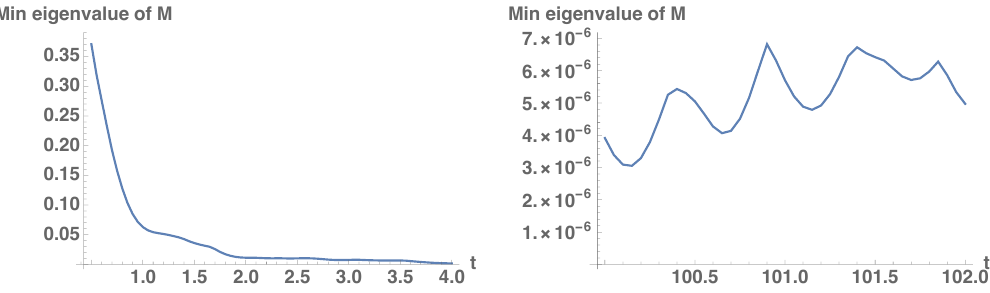
Figure 5 . (Left) The minimum eigenvalue of e − S M αβ , i.e., the impact parameter, for an SYK Hamiltonian with N = 10 , q = 3 , k = 3 , J = 1 at small times. (Right) The minimum eigenvalue past exponential time becomes very